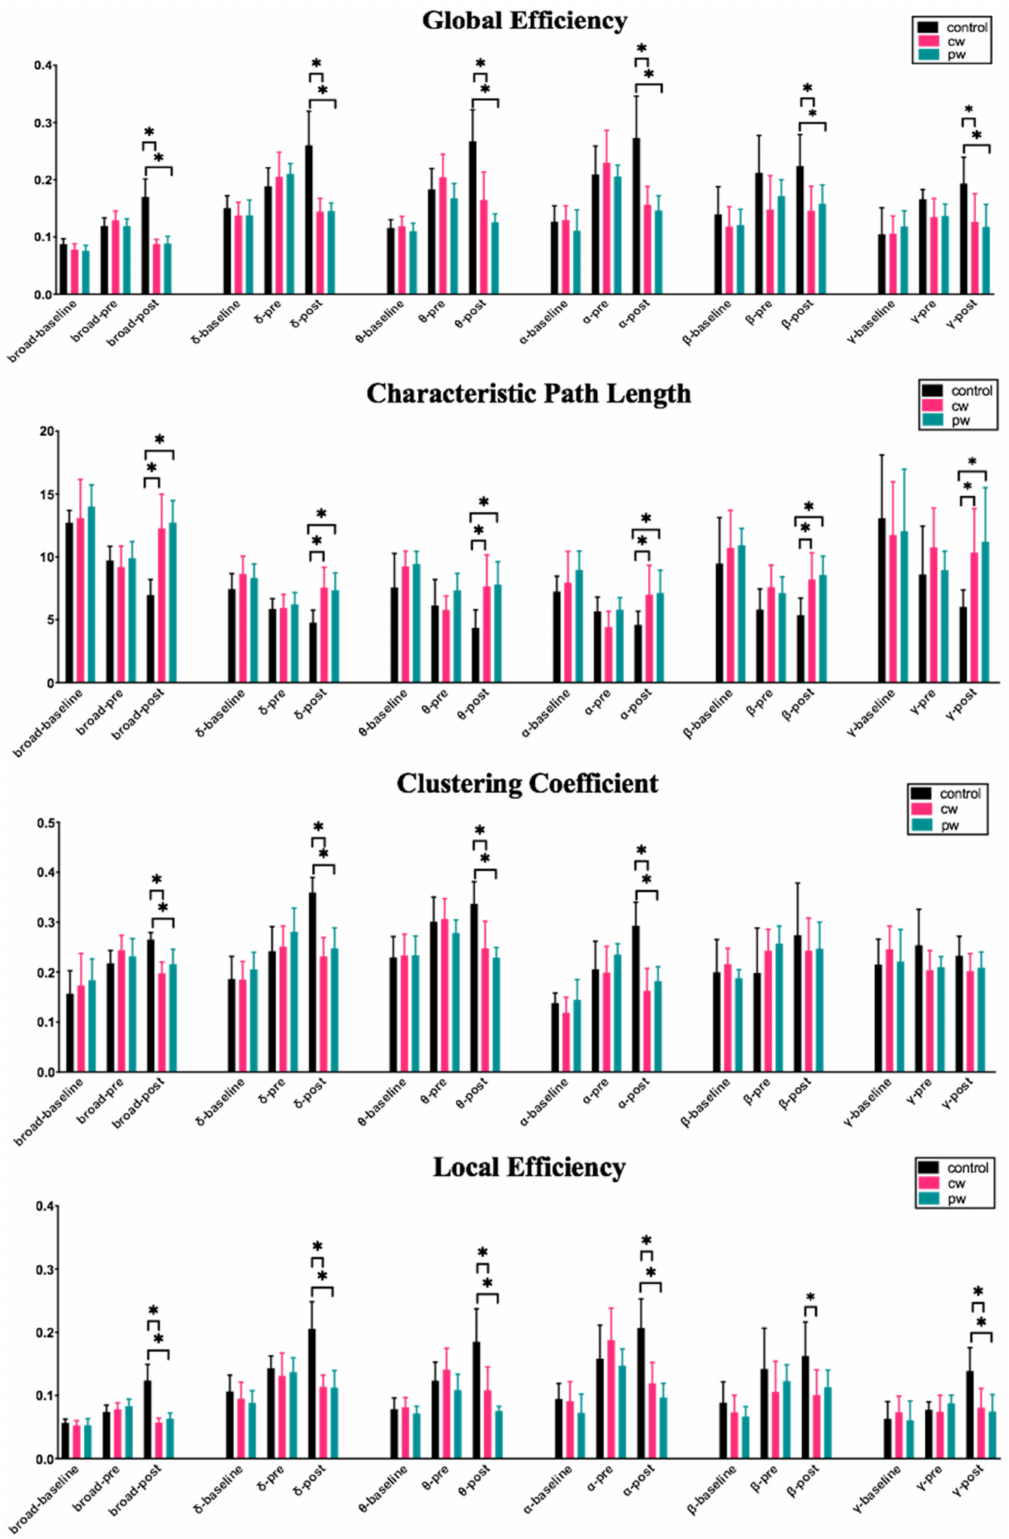
Figure 9. Intergroup analysis comparisons of brain functional connectivity indicators (L p , C p , E g , and E loc ) for all filtered bands (delta 0.1–4 Hz, theta 4–8 Hz, alpha 8–13 Hz, beta 13–30 Hz, and gamma 30–48 Hz) and the broad-filtered EEG (0.1–48 Hz). * p <